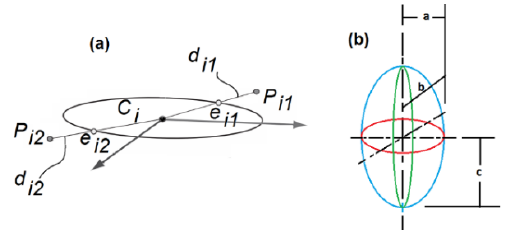
Figure 1. ( a ) Displacement of a point on ellipsoidal section and ( b ) the axial directions considered for this analysis.